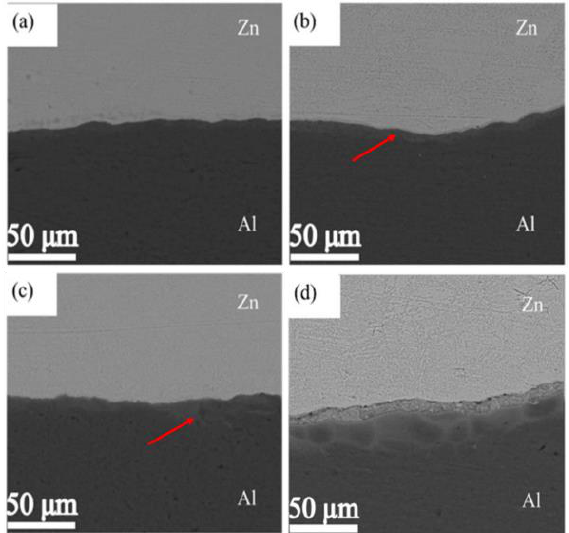
Figure 4. SEM morphology images of interface at different annealing temperatures for 1.5 h. ( a ) 200 °C; ( b ) 240 °C; ( c ) 280 °C; ( d ) 320 °C.